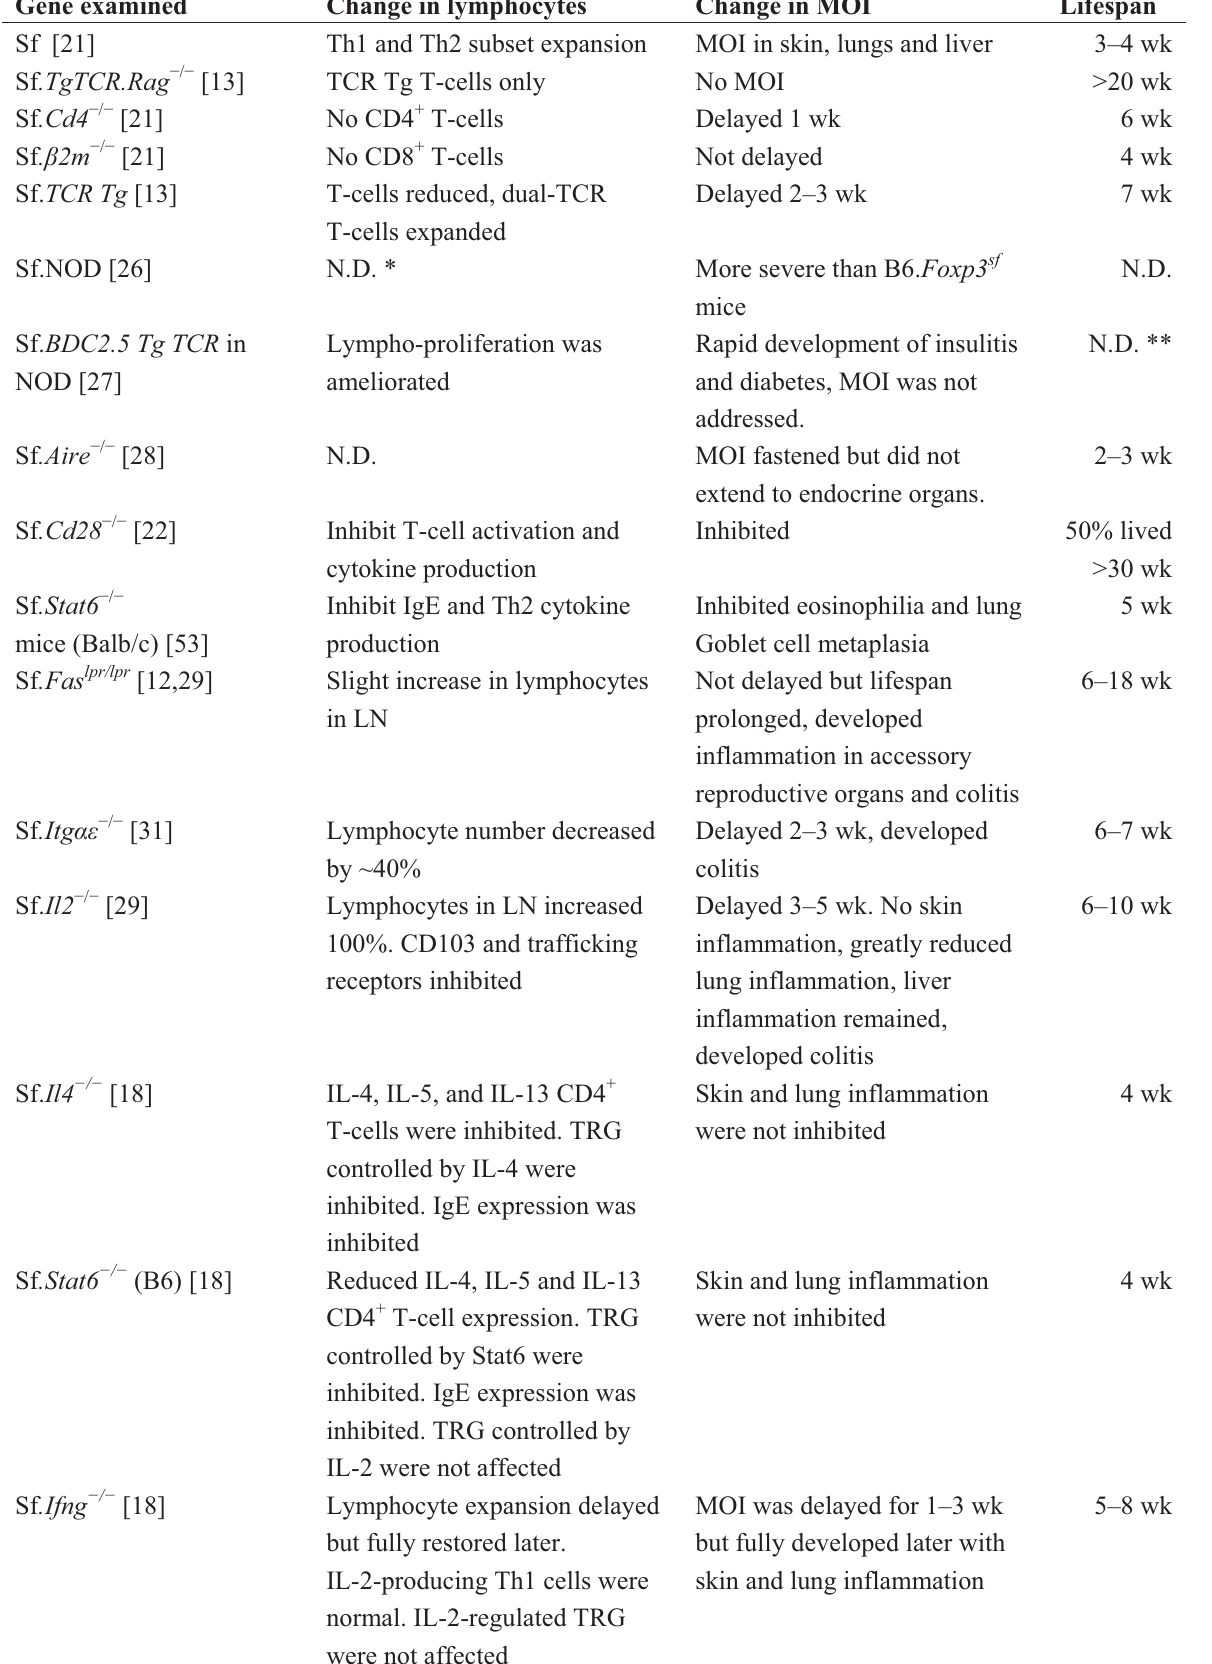
Table 1. Changes of lymphocyte subsets, MOI, and lifespan of various Sf double mutant mice. Gene